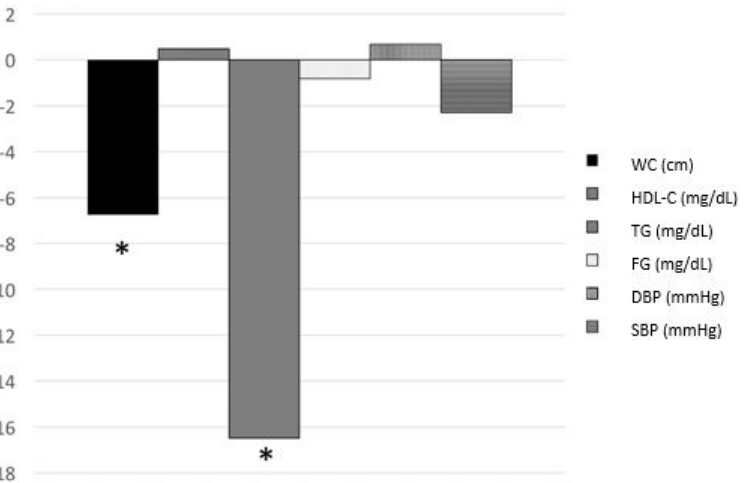
Figure 3. Changes of metabolic parameters after a 6-month intervention in the total study sample. WC-waist circumference, HDL-C-high-density lipoprotein cholesterol, TG-triglycerides, FG-fasting glucose, DBP-diastolic blood pressure, SBP-systolic blood pressure, * p < 0.05. Few correlations were found for the total sample between the changes in metabolic parameters and changes in the ectopic fat deposition: SBP was the only variable that correlated with the change in VAT after three months (R 2 = 0.427, p = 0.003). Furthermore, changes in WC were weakly to moderately and positively correlated with VAT changes ( p < 0.05).